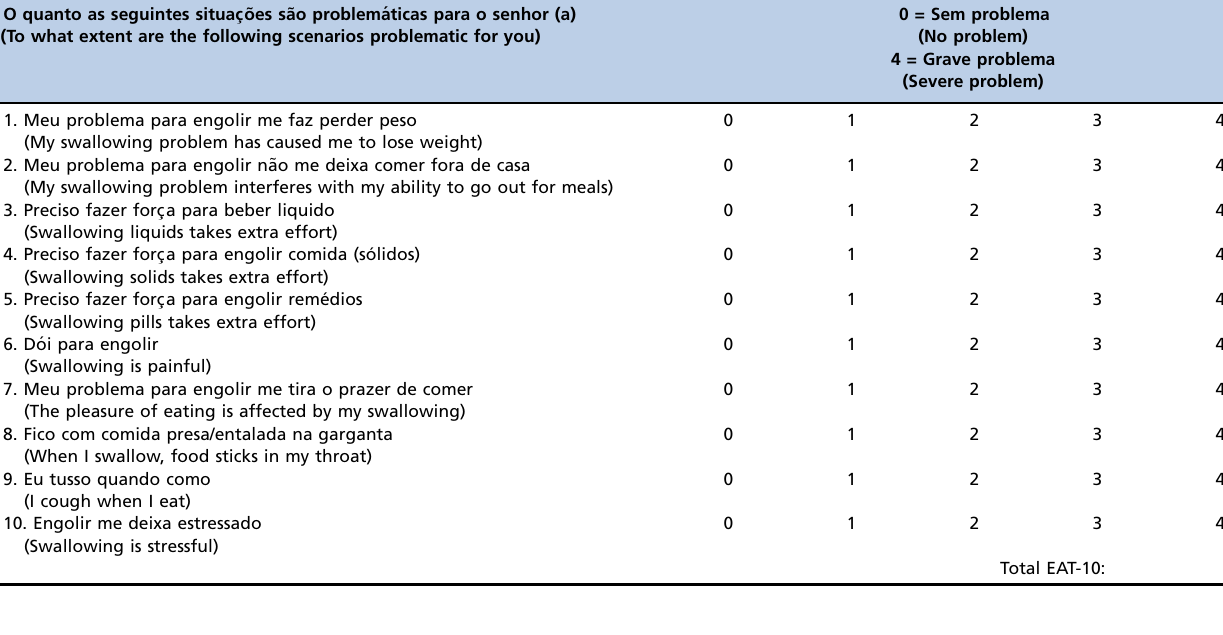
Table 2 - Eating Assessment Tool (EAT-10) in Brazilian Portuguese.